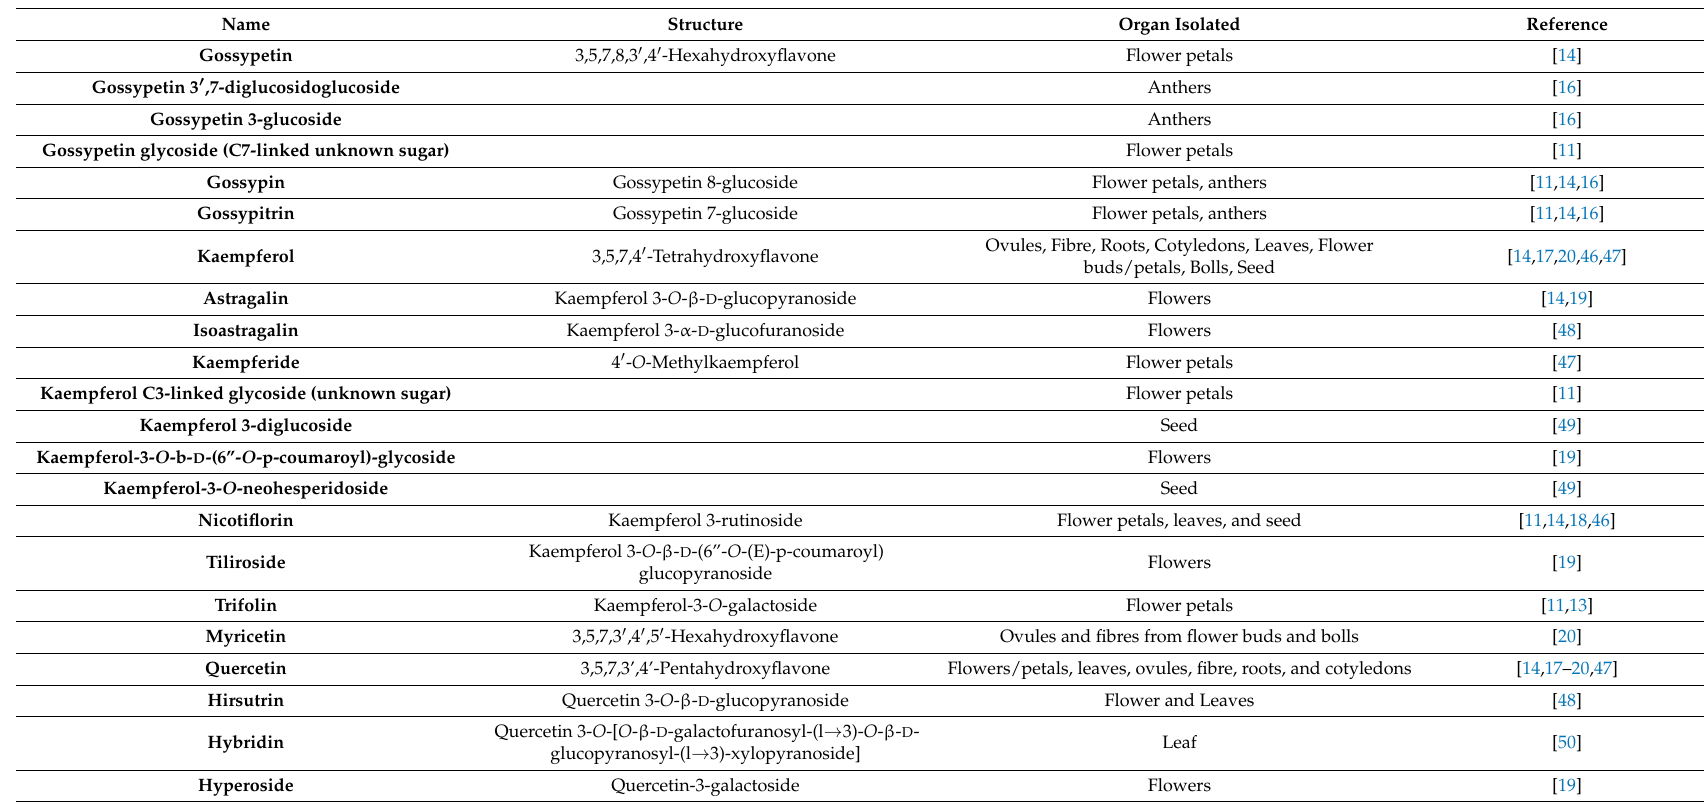
Table 2. Distribution of flavonols in Gossypium